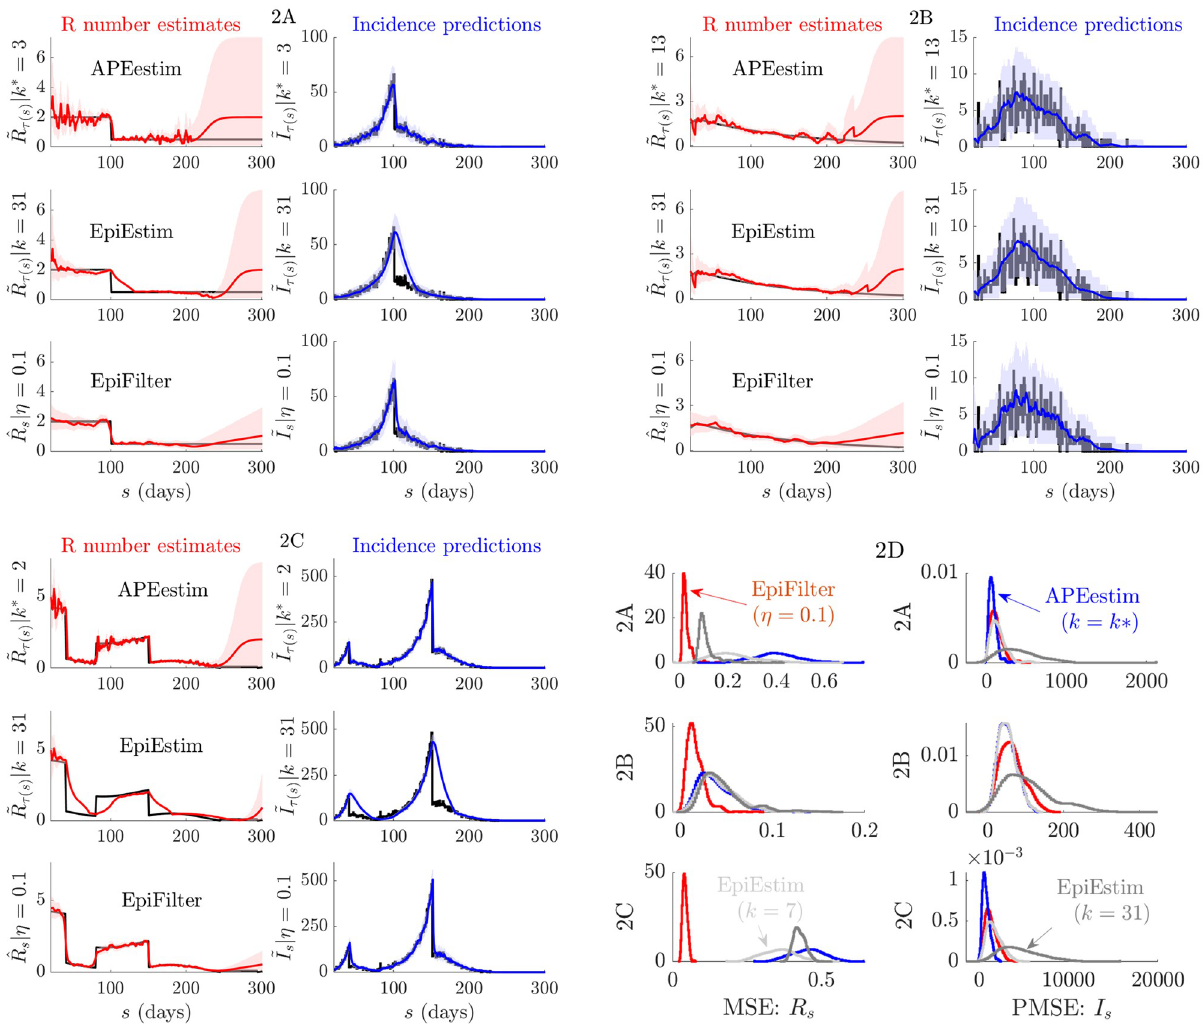
Fig 2. Small or waning epidemics. We compare reproduction number estimates ( ~ R from APEestim with optimal window k � , EpiEstim with window k and EpiFilter with state noise η . We simulate 200 epidemics with low daily case numbers or long tails (long sequences of zero cases) using the standard renewal model (Eq (1)) for three scenarios, representative examples of which are given in A-C. The true R s and I s are in black. All mean estimates or predictions are in red and blue with 95% credible intervals. APEestim and EpiEstim use a Gam(1, 2) prior distribution and EpiFilter a grid with m = 2000, R min = 0.01 and R max = 10. In D we provide statistics of the MSE of these estimates (relative to R s ) and the PMSE of these predictions (relative to I s ) for all 200 runs. We find that EpiFilter is more robust to small incidence (better uncertainty), whereas the other approaches can quickly decay to their prior distribution. It achieves significantly smaller MSE (2–10 fold reductions) and comparable PMSE to APEestim (which is optimised for